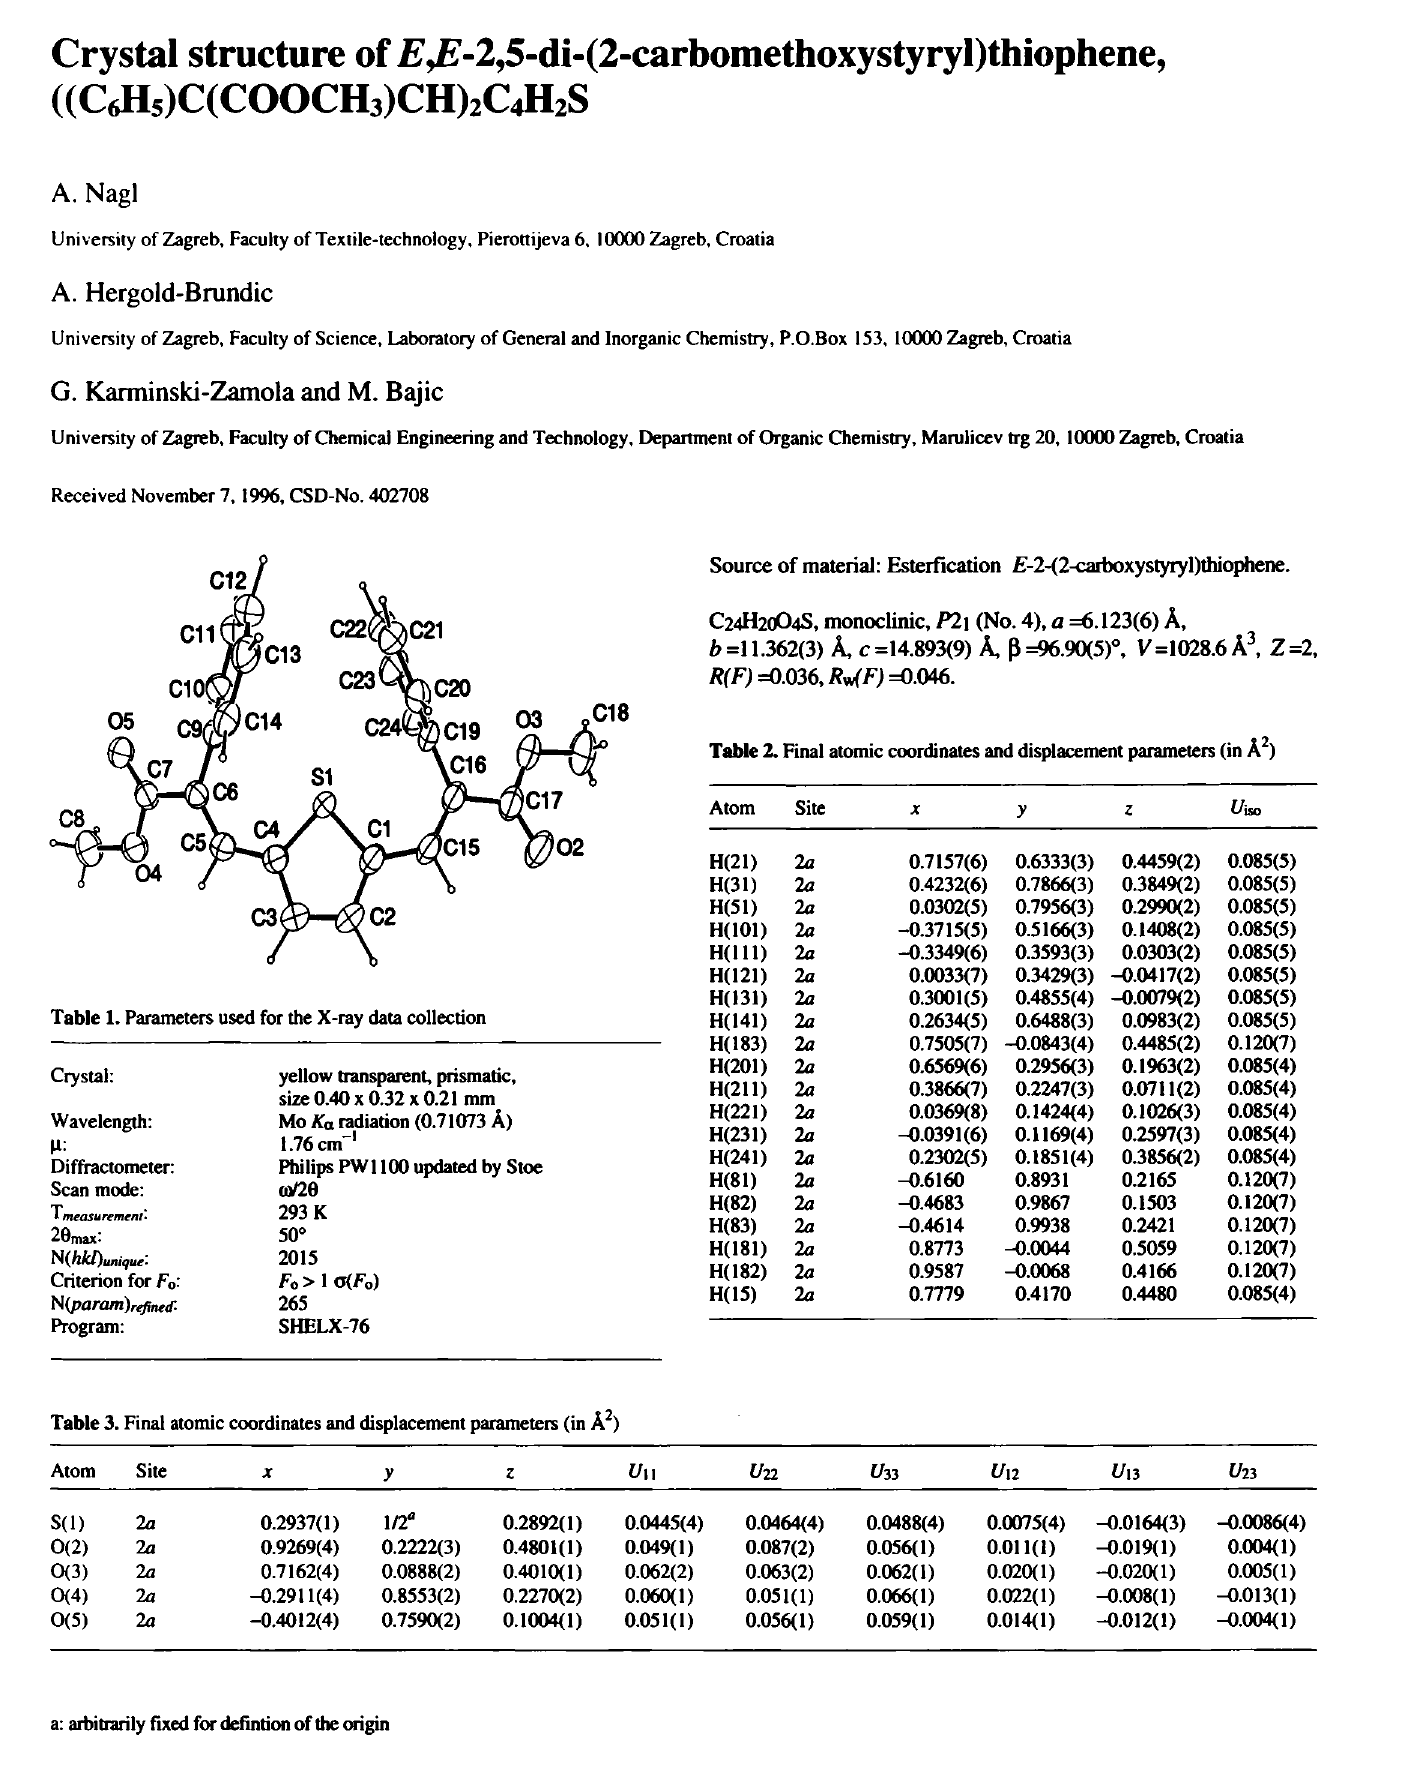
Table 3. Final atomic coordinates and displacement parameters (in Â 2 )